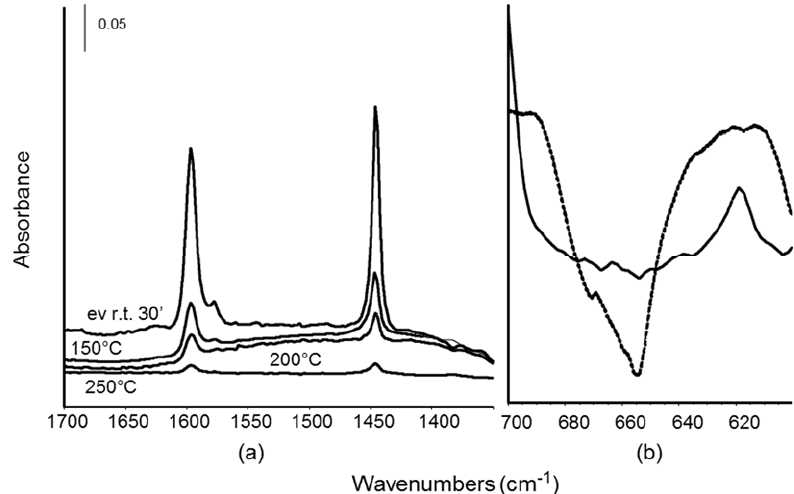
Figure 4. FT ‐ IR subtraction spectra: ( a ) Surface species arising from pyridine adsorption over 30Co/SBA catalyst after pretreatment in 1,2DCP at 180 °C (the spectrum of the surface after 1,2DCP reaction has been subtracted); and, ( b ) enlargement of the low frequency spectral region of the 30Co/SBA sample after pretreatment in 1,2DCP at 180 °C (solid line) after pre ‐ treatment at high temperatures (broken line).